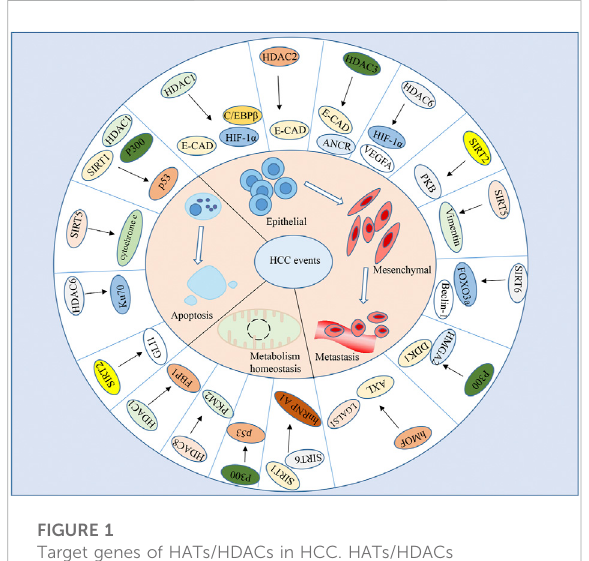
FIGURE 1 Target genes of HATs/HDACs in HCC. HATs/HDACs mediated-histone modi fi cations affect key protein function that govern a wide array of biological processes in HCC metastasis, apoptosis, and metabolic